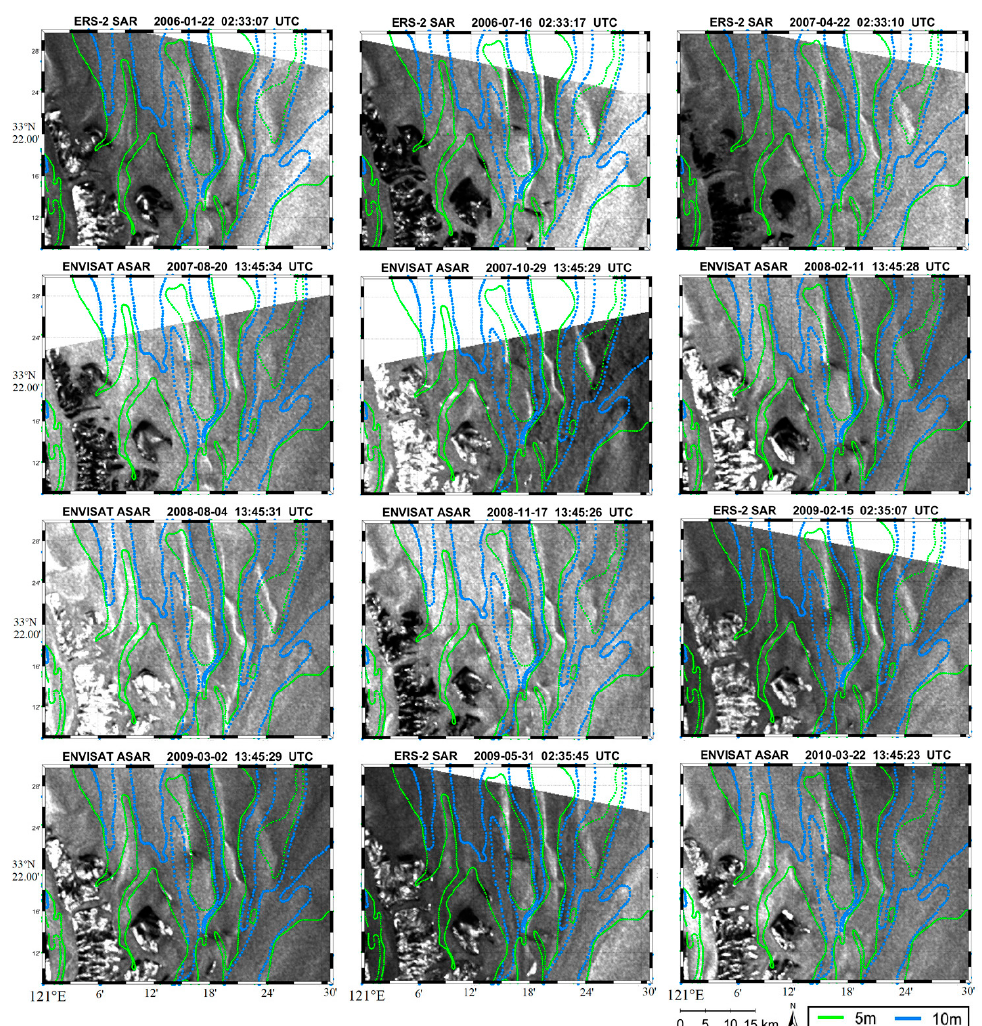
Figure 6. Same as Figure 4 but for SAR sub-images with bathymetric features shown as narrow bright stripes.